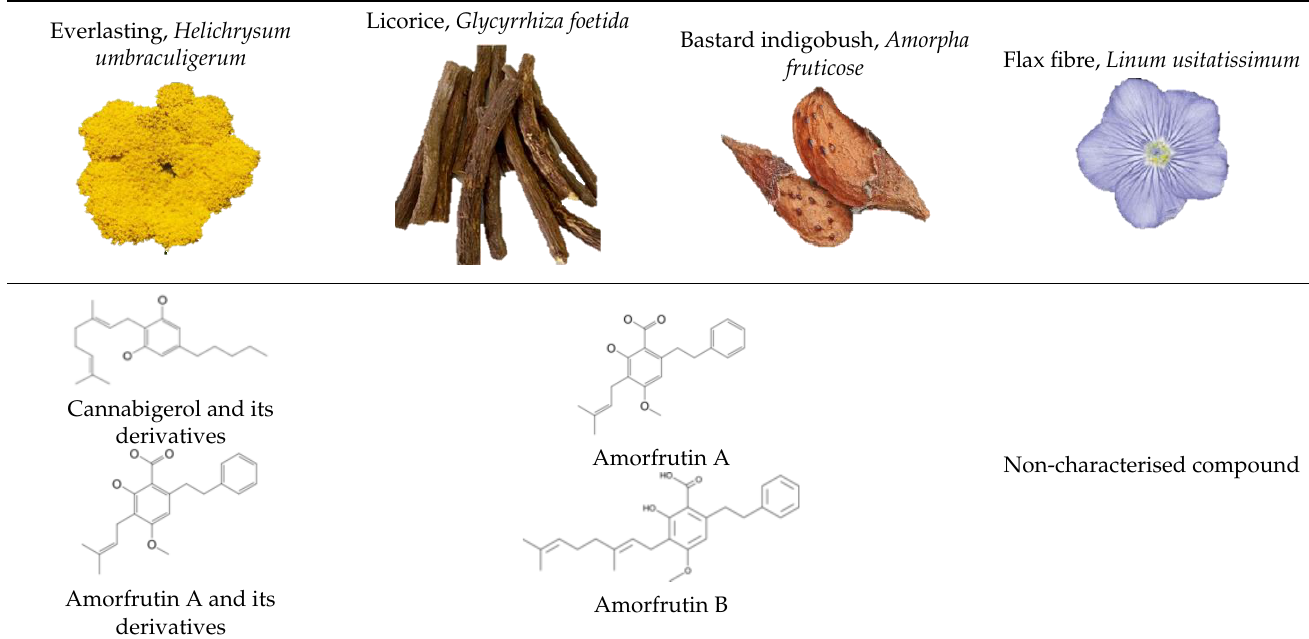
Table 3. Phytocannabinoid structures from different angiosperm species.